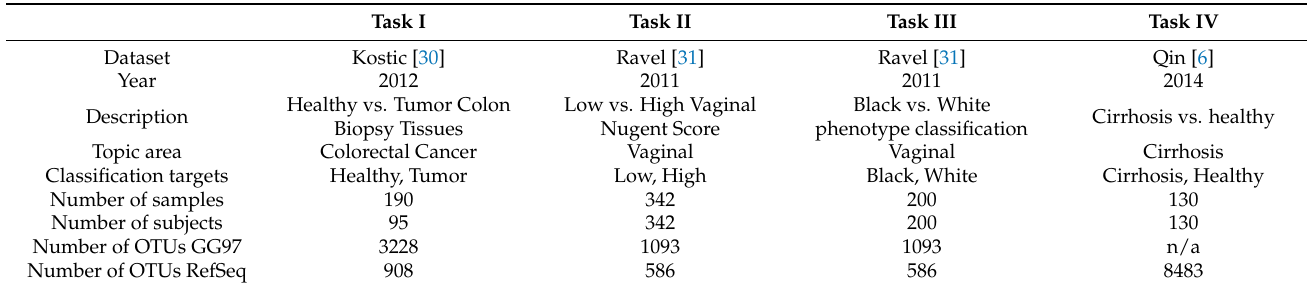
Table 1. Description of datasets used in this study.